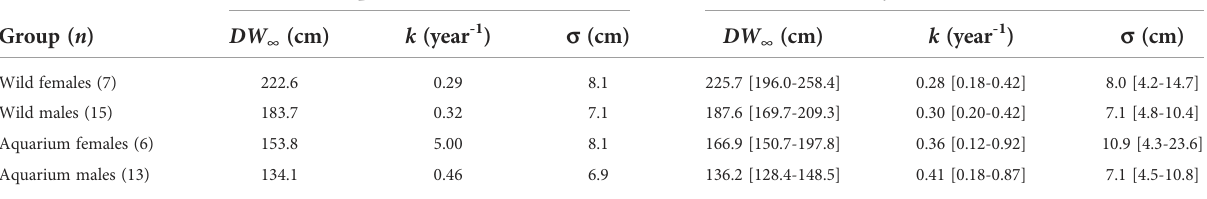
TABLE 3 von Bertalanffy growth parameter